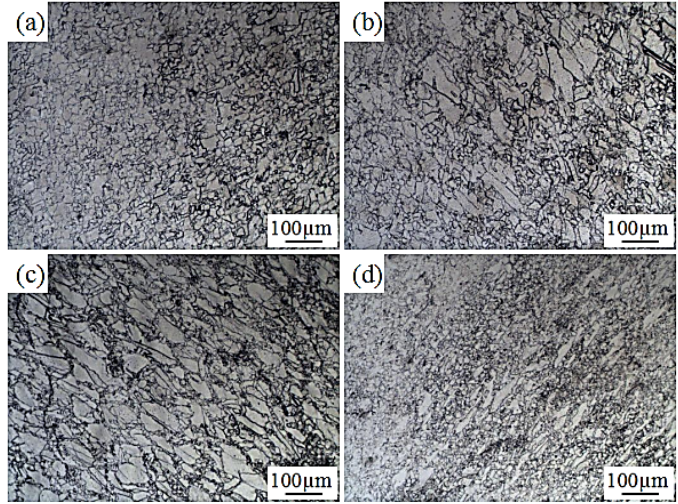
Figure 5. Microstructure of GH901 superalloy deformed at 1090 °C ( a ) Microstructure at 0.001 s − 1 ( b ) Microstructure at 0.01 s − 1 ( c ) Microstructure at 0.1 s − 1 ( d ) Microstructure at 1 s − 1 .